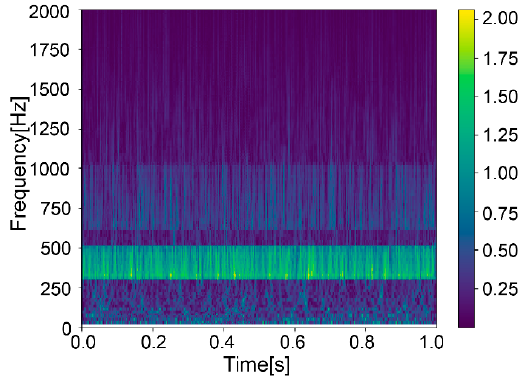
Figure 6. Time–frequency graph in wavelet transform.